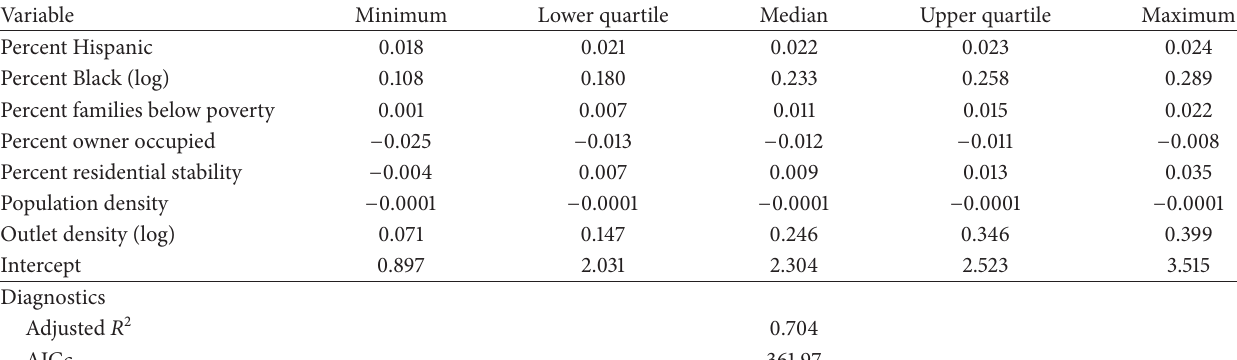
Table 3: Geographically weighted regression (GWR) model of violent crime (local